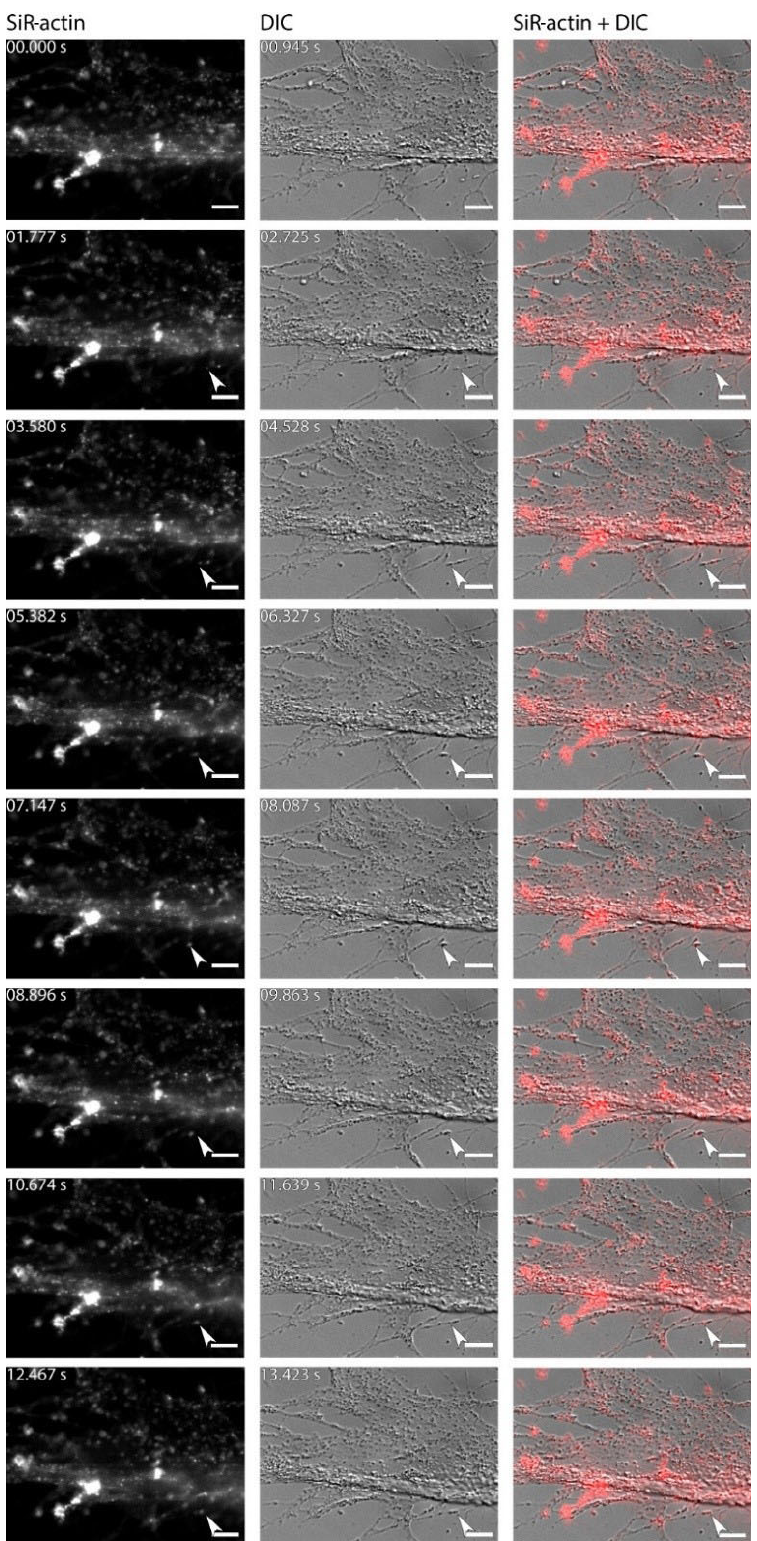
Figure 6. Dynamics of SiR-actin-labelled granules (ALGs) in reticulopodia of Amphistegina lessonii . Eight frames of the time-lapse. Right column: actin stained with SiR actin; middle column: DIC; right column: overlay of fluorescent and DIC channels. Arrows indicate a granule in the tip of one very fine thread of forming pseudopodium. The numbers in top-right corner of each image of SiR actin and DIC channels indicate the time of acquisition. Conventional fluorescence images were obtained with a Zeiss Axio Observer Z1 (scale bar